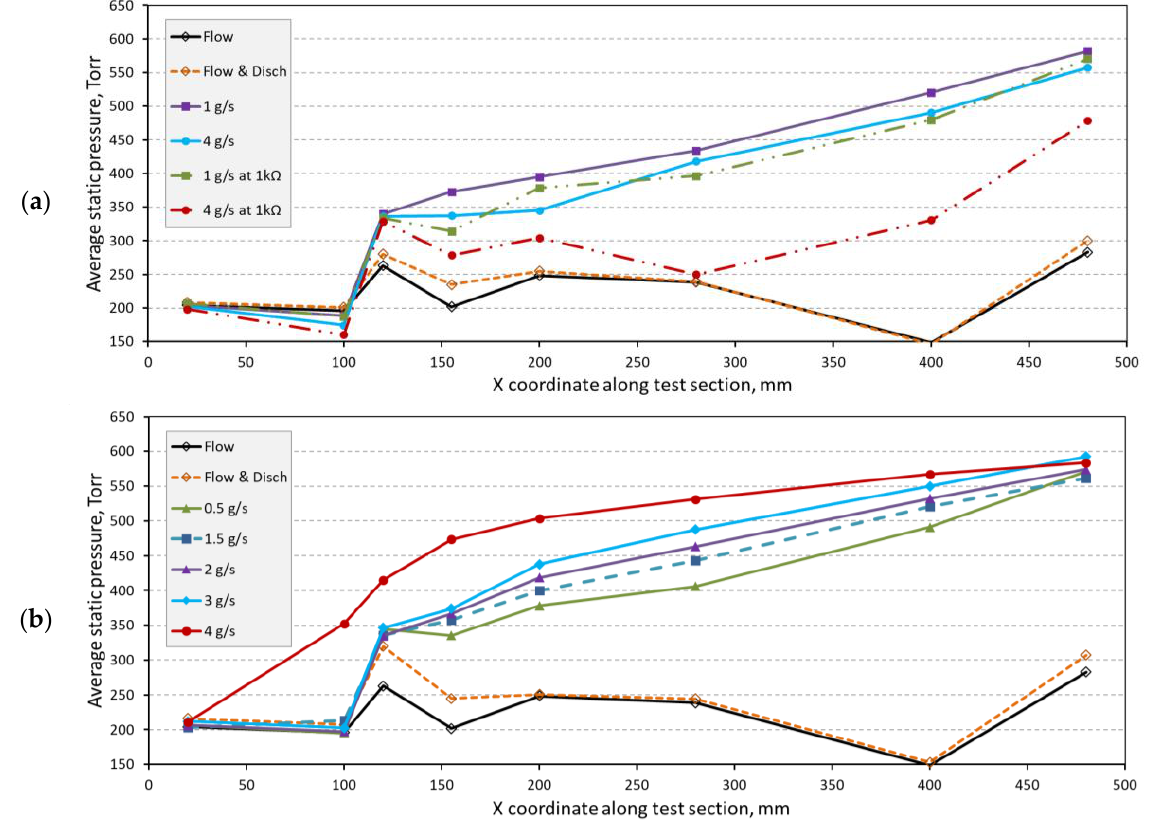
Figure 8. Static pressure distribution for pylon ver.b in the case of ballast resistance of ( a ) 750 and 1 k Ω; and ( b ) 500 Ω. The pylon is located between 50 and 80 mm, and the ends of the electrodes are located at 120 mm.